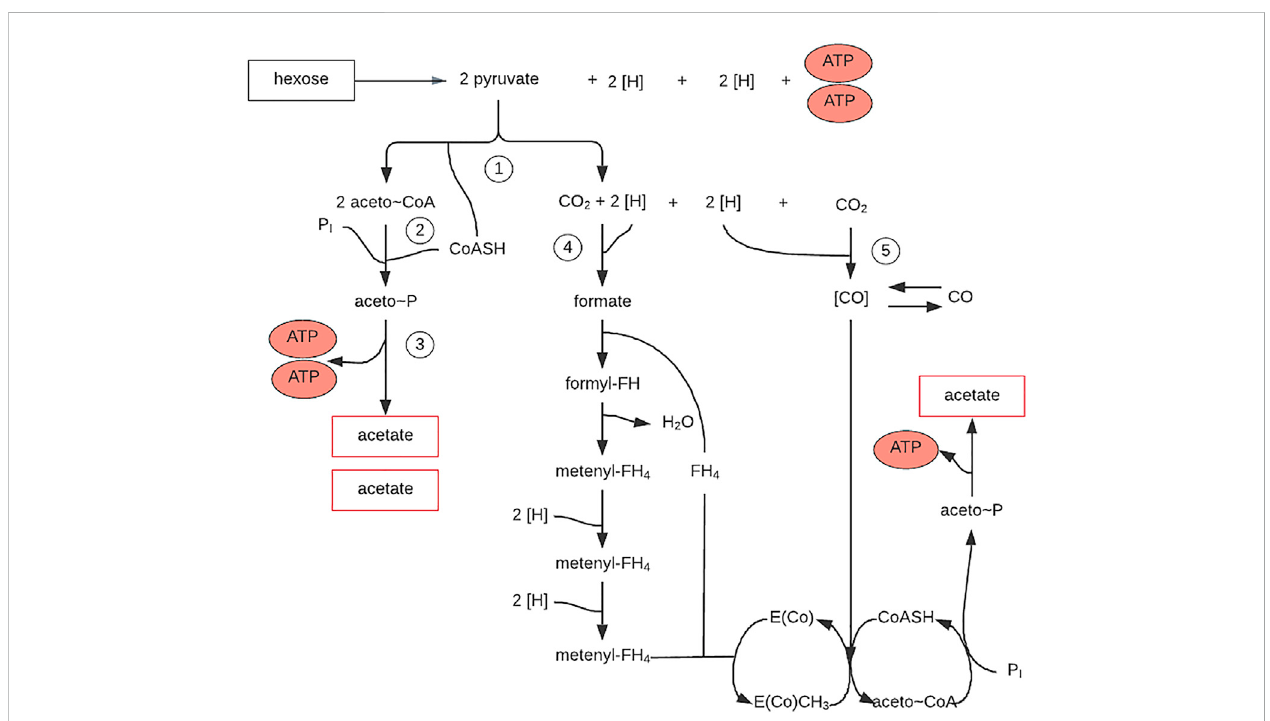
FIGURE 9 Acetate biosynthesis pathway from hexose ( via the Acetyl-CoA pathway) in Clostriudium thermoaceticum . E (Co), corrinoid protein; FH4, tetrahydrofolic acid; (H), hydrogen equivalents in the form of NADH 2 or FdH 2 ; CO, exogenous carbon monoxide; (CO), bound carbon monoxide. Figure redrawn after reference (Schlegel,